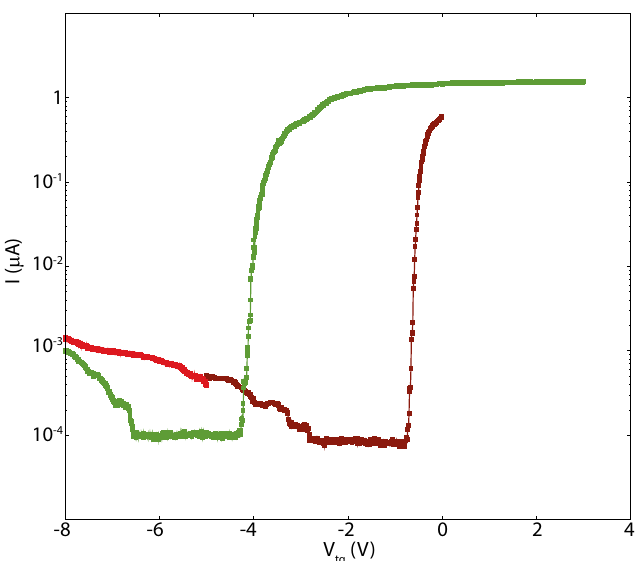
Figure S2: Bipolar transport in device 3. Global backgate voltage = -30V, B = 0T, = 10mV. An offset of 0.2 nA was added for log-scale plotting. Three different V bias colors represent 3 different datasets, taken one after another. Red colors were taken with increase in topgate voltage, while green color line represents decreasing voltage. Gate hysteresis is typical for large-range gate sweeps.